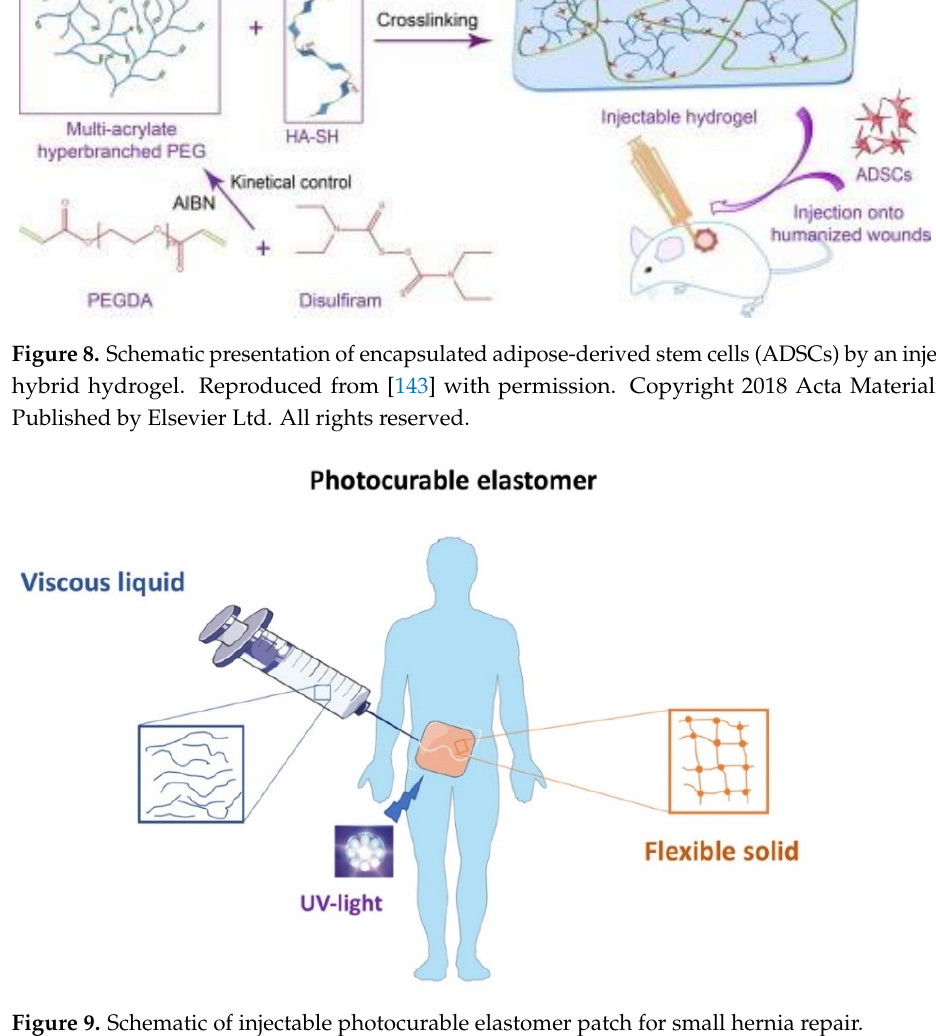
Figure 9. Schematic of injectable photocurable elastomer patch for small hernia repair.